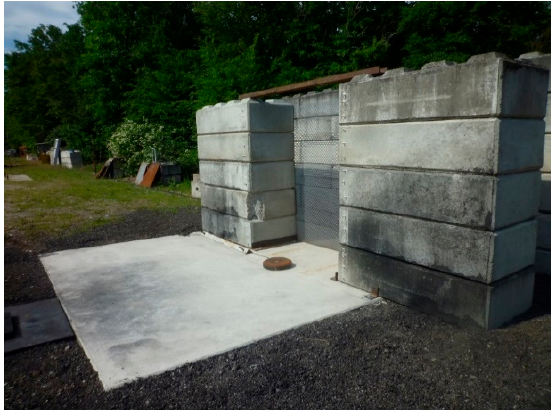
Figure 6. View of the experimental setup showing the one-grid configuration: the grid position, concrete blocks and gauge in front of the grid.